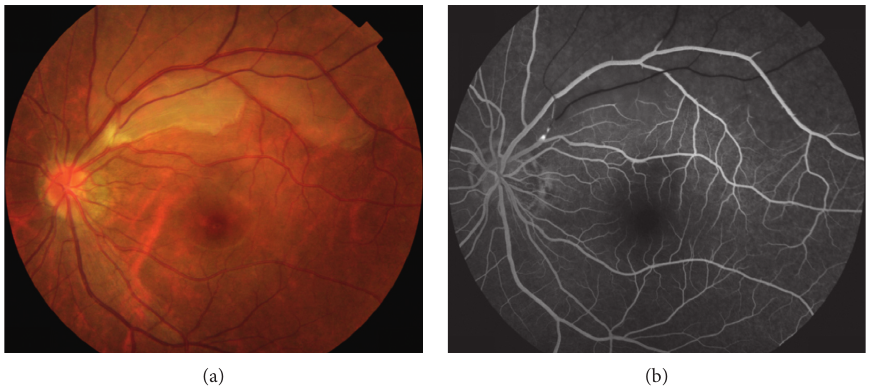
Figure 1: Fundus photograph of the left eye demonstrated plaque and mild edema of the supertemporal retina. Corresponding fluorescein angiogram highlighted hyperfluorescence and nonfilling of the supertemporal artery.